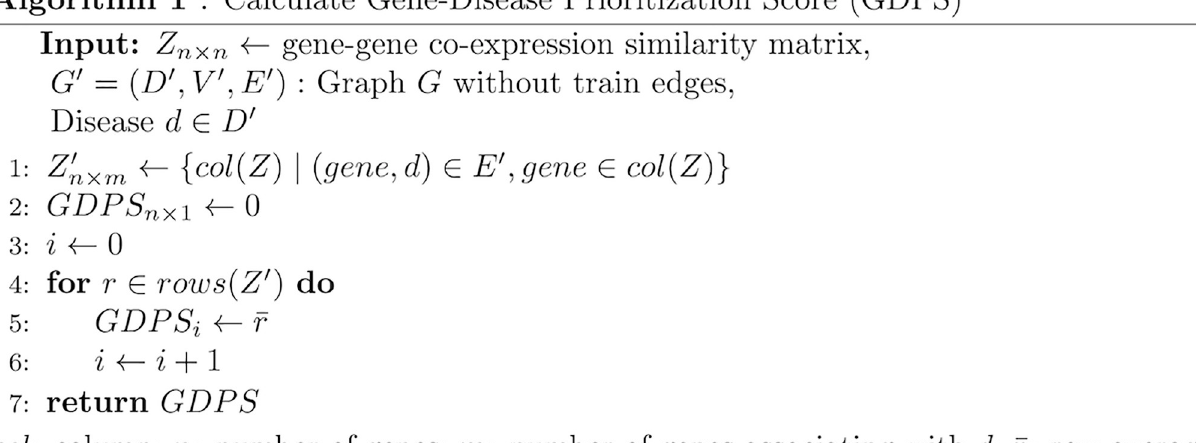
Fig 1. The developed algorithm to calculate Gene-Disease Prioritization Score (GDPS).